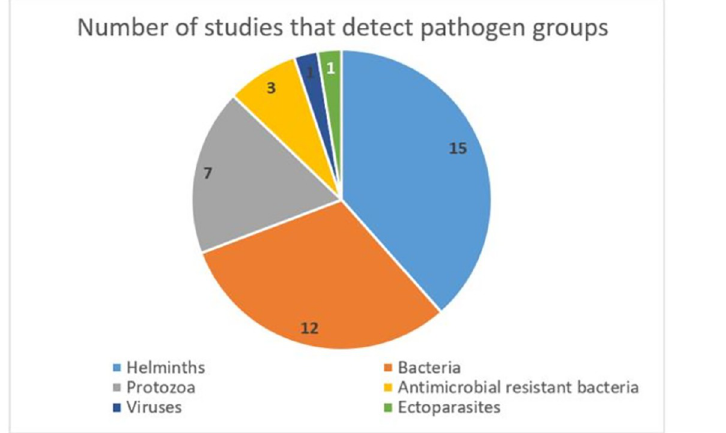
Fig 4. Number of studies that detect pathogen